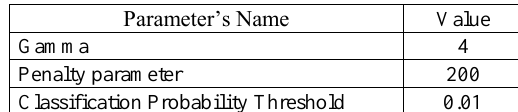
Figure 1. Structure of the proposed road recognition method In the following sections of this paper, texture feature extraction and SVM classification are explained for each of the SPOT and SAR images, separately.